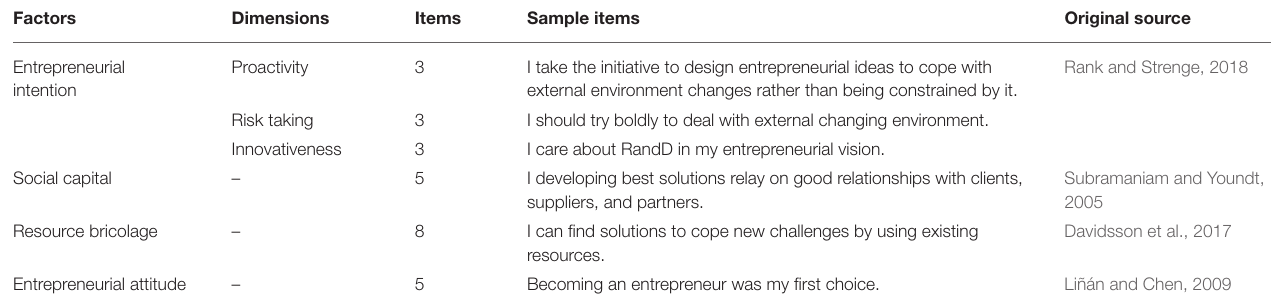
TABLE 1 | The Items and dimensions of the developed questionnaire.